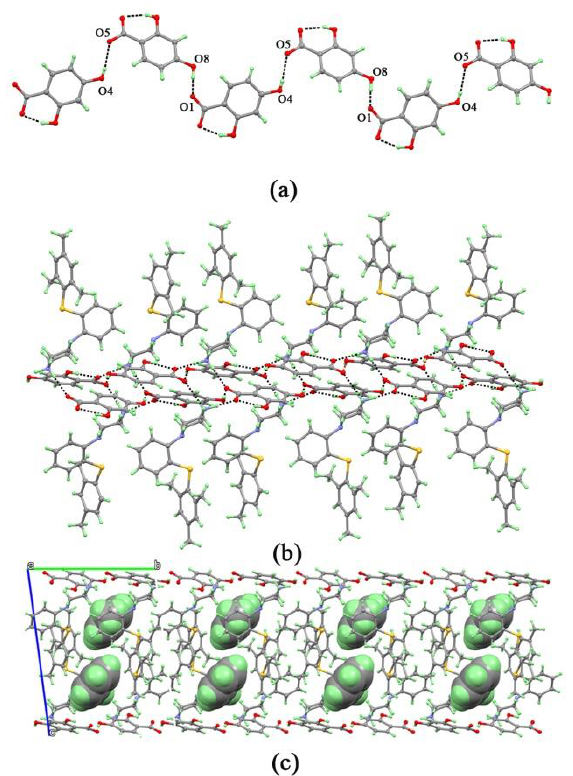
Figure 2. ( a ) Two 24BA anions interacted with each other to form a one-dimensional chain structure. ( b ) The complex 3D structure of the VOT-24BA-TOL salt. ( c ) The toluene molecules existed in the cavity of the VOT-24BA-TOL salt.